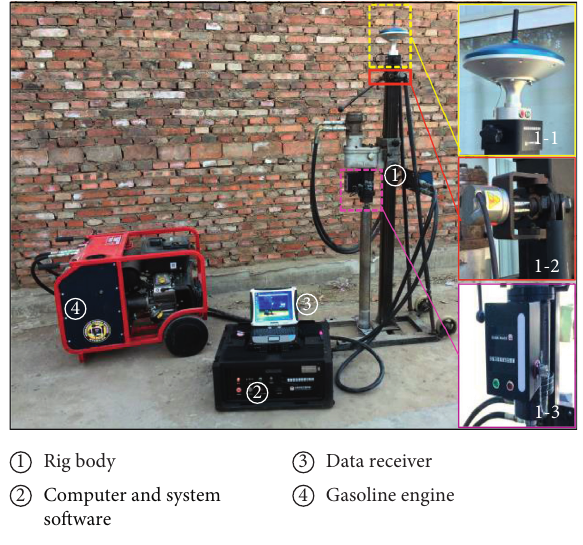
Figure 5: Drilling